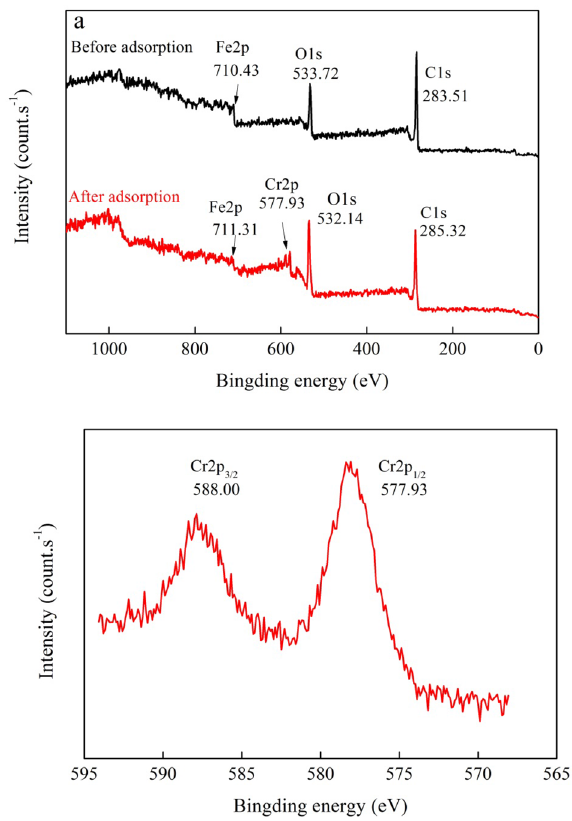
Figure 7. XPS spectra of BMBC before ( a ) and after ( b ) adsorption of Cr(VI).